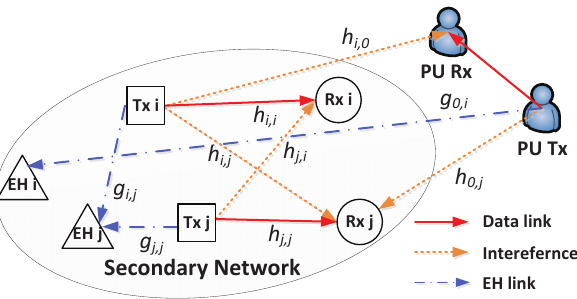
Figure 1. System model of WPCRNs for secure communications with N =